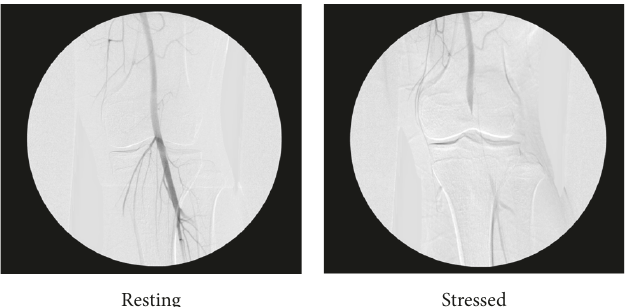
Figure 1: Stress CT angiography, left lower extremity. Notice near complete cessation of flow in the popliteal artery during the stressed or active phase of angiography.